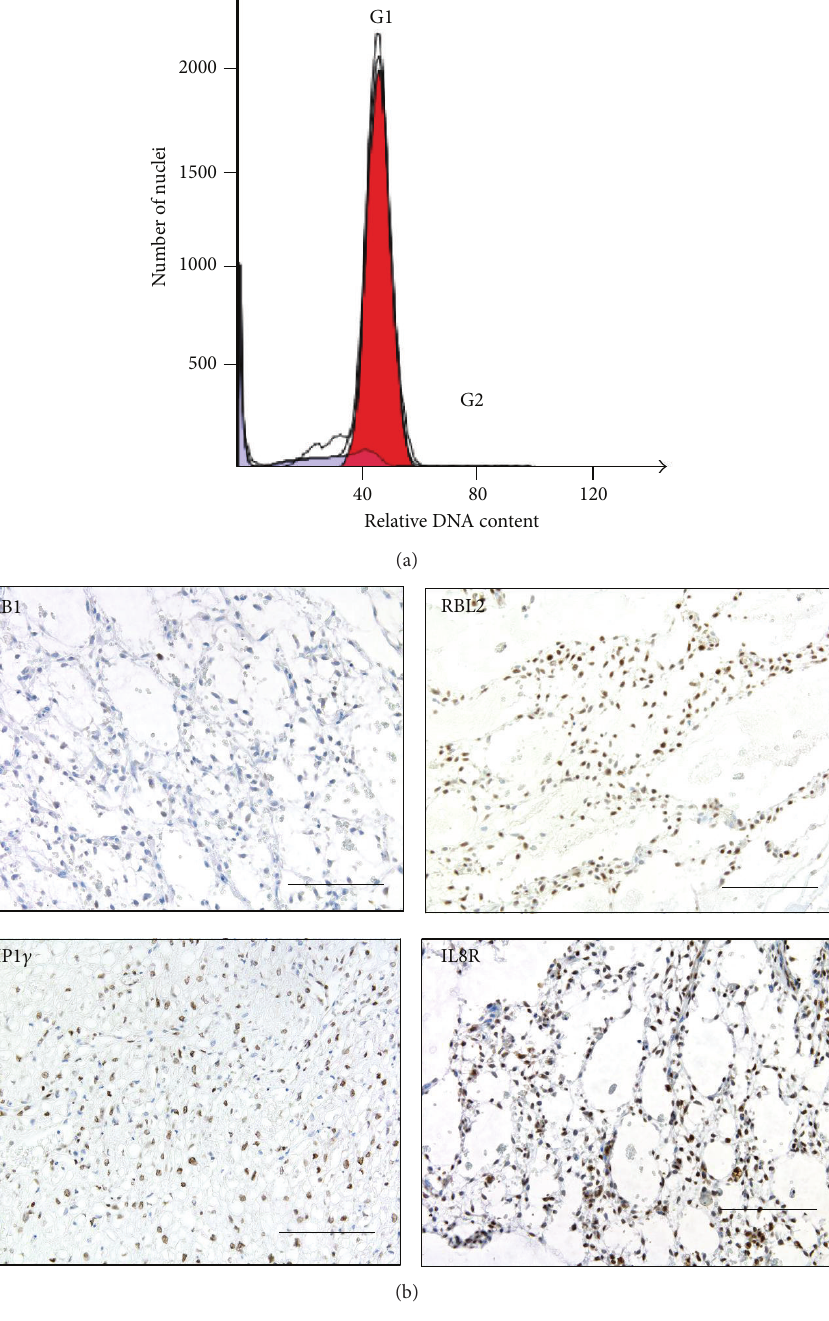
Figure 1: (a) Flow cytometry histogram of cell nuclei extracted from paraffin embedded MLS/RCLS tumor tissue (Cases 8) showing more than 95% of the cells in the G1 phase of the cell cycle (red). (b) Immunohistochemistry analysis of RB1, RBL2, HP1 𝛾 , and IL8R in MLS/RCLS tumor tissues. Brown staining shows reactivity with the specific antibodies. Bars are 100 𝜇